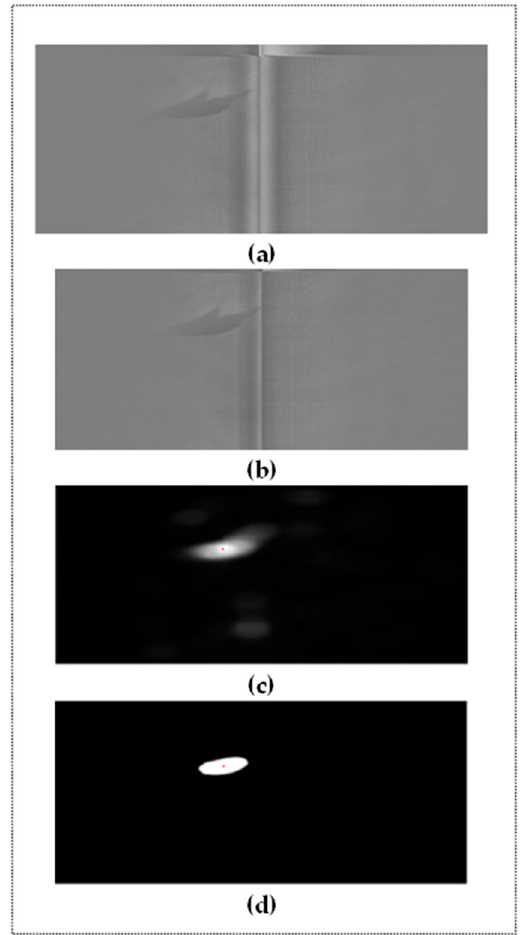
Figure 5. Example of candidate region detection process: ( a ) Original SLAR image; ( b ) New image without noise (i.e., we have applied the process shown in Figure 4); ( c ) Saliency map with spectral residue; ( d ) Thresholding and centroids.